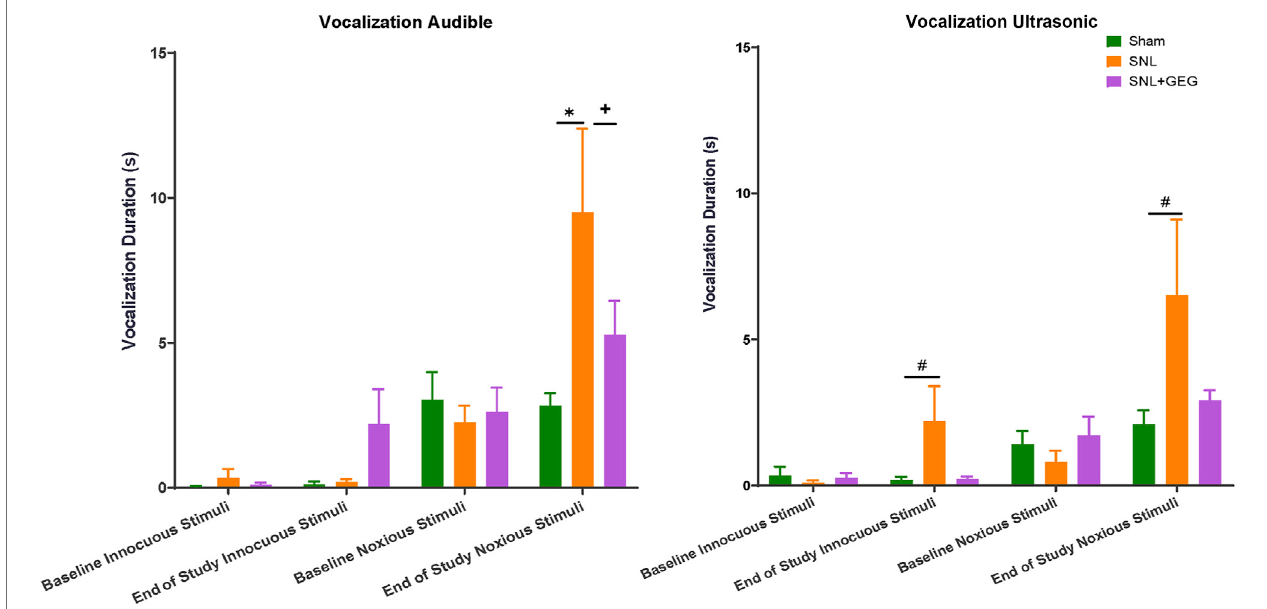
FIGURE 3 | Effect of GEG supplementation on audible, pain-induced vocalizations in response to innocuous stimuli (left) and noxious stimuli (right). Data is expressed asmean±SEM. n =5 – 6pergroup.Datawasanalyzedbyone-wayANOVAfollowedbya posthoc Tukey ’ stestateachtimepoint.* p < 0.05.vsSham. # 0.05 < p < 0.1 vs Sham. + p < 0.05 vs